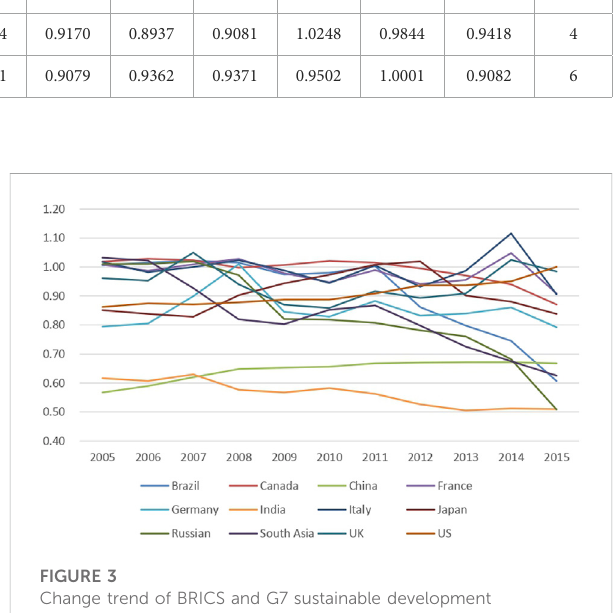
FIGURE 3 Change trend of BRICS and G7 sustainable development ef fi